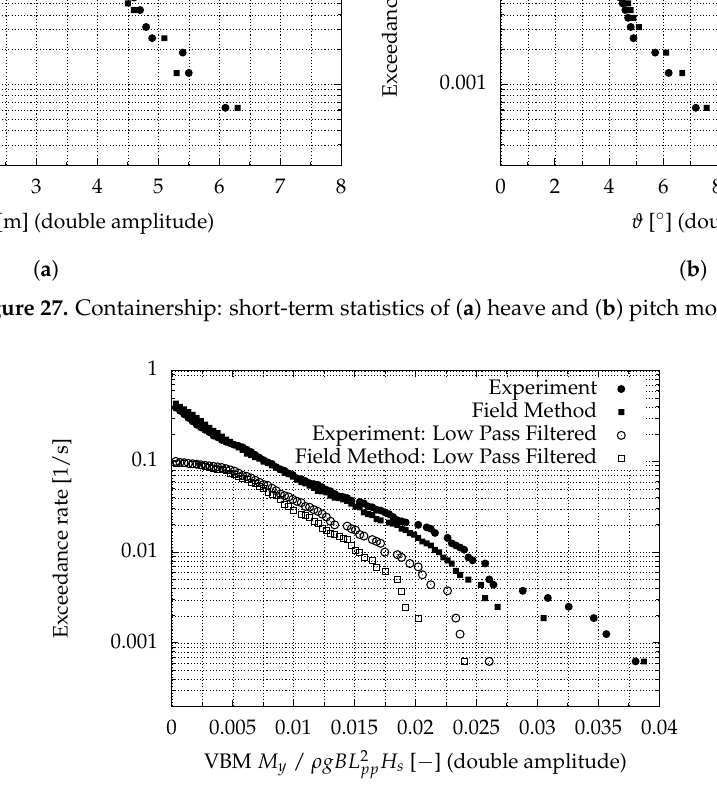
Figure 28. Containership: short-term statistics of midship vertical bending